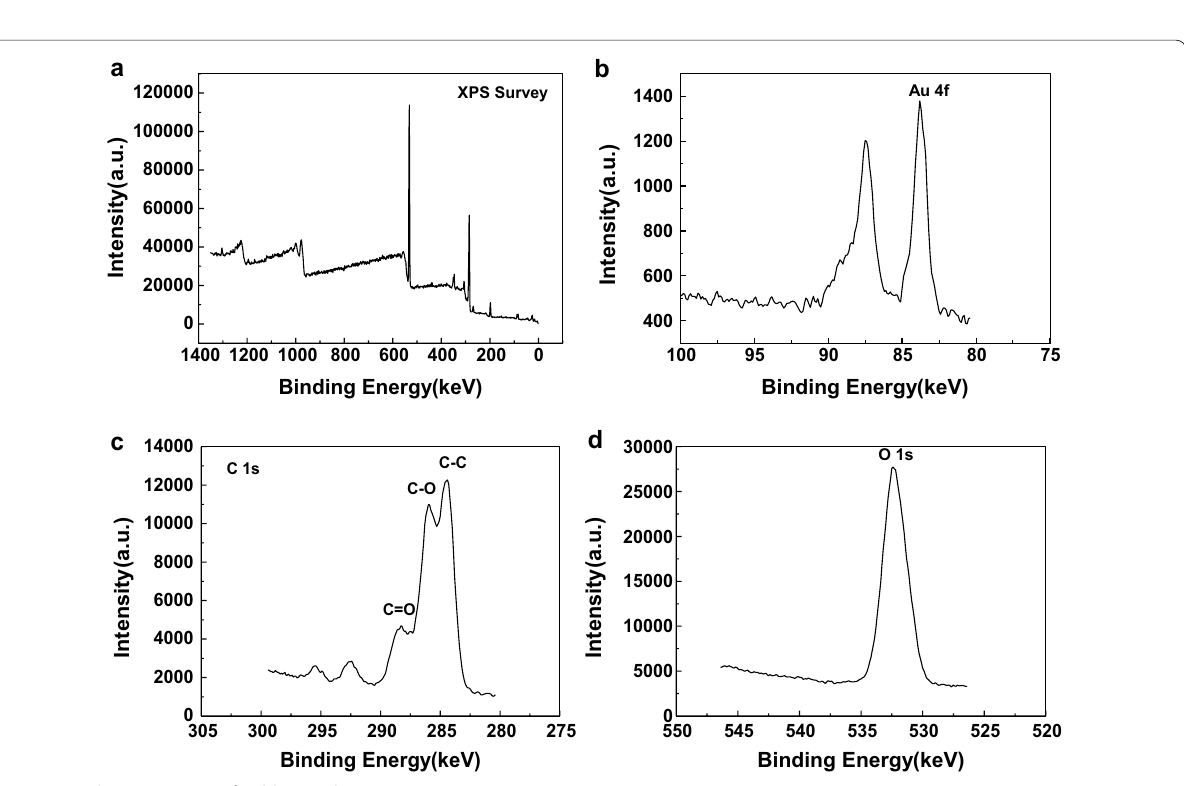
Fig. 7 XPS characterization of gold